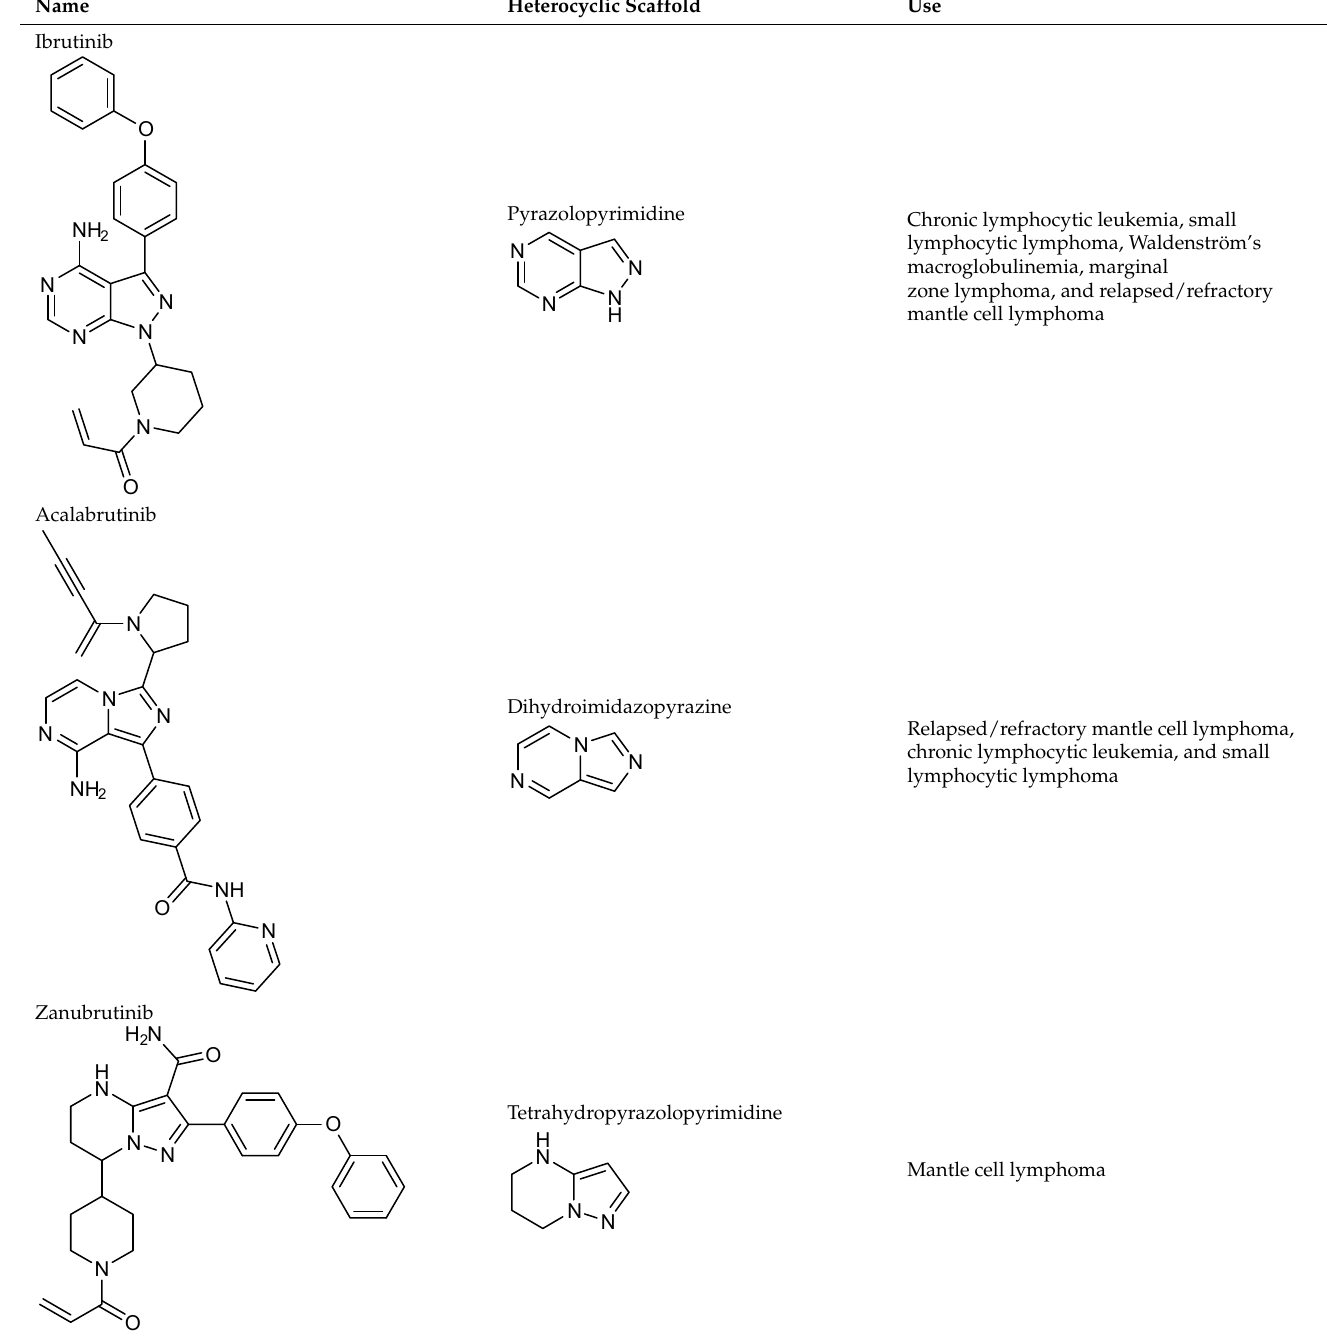
Table 1. Approved covalent inhibitors of BTK.